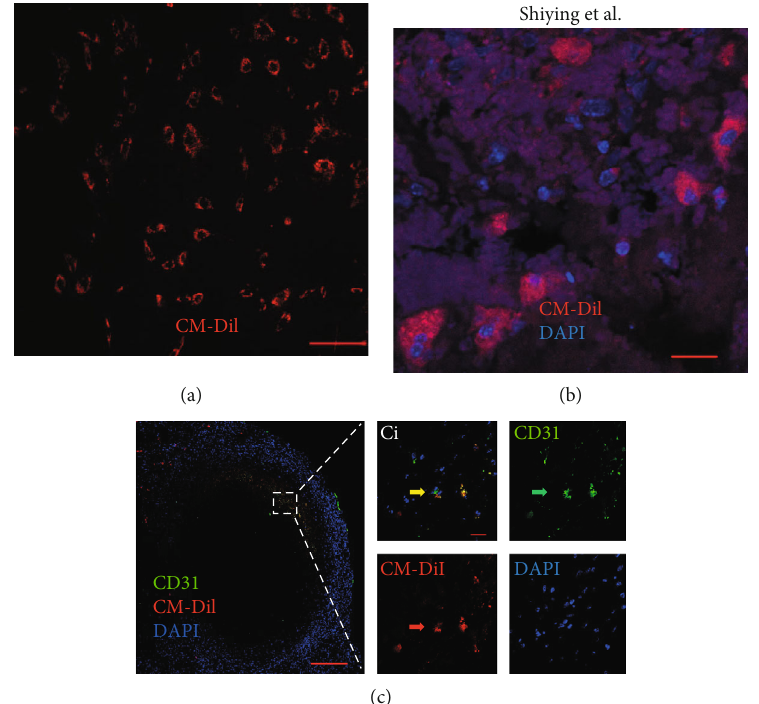
Figure 6: The migration and di ff erentiation of labeled CD34 + CD117 + HGSV-AdPC in 7-days thrombus of mice. (a) CD34 + CD117 + HGSV- AdPC labeled with fl uorescent molecular probe (CM-Dil) before transplantation. (b) The CM-Dil-labeled CD34 + CD117 + HGSV-AdPC entered into thrombus. (c) The labeled CD34 + CD117 + HGSV-AdPC di ff erentiated into CD31 + endothelial cells. Scale bars: 20 μ m (a, b and Ci); 200 μ m (c). Magni fi cation: 200x (a); 400x (b); 100x